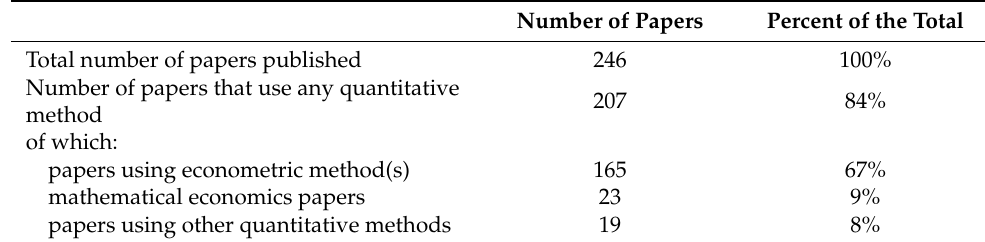
Table 3. Summary of the survey’s main findings. Number of Papers Percent of the Total Total number of papers published 246 100%